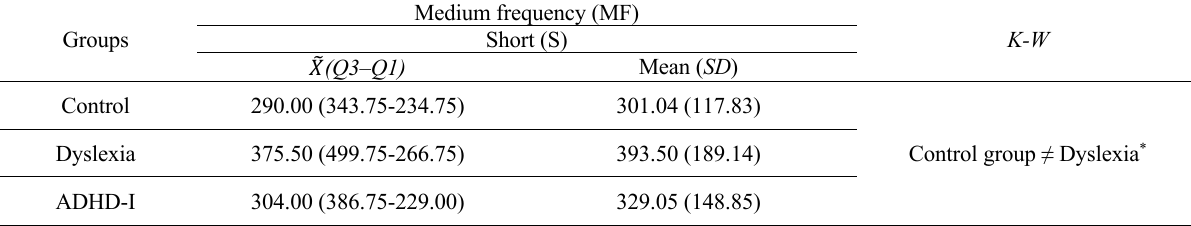
Table 6 – Median and Mean SFD duration (in milliseconds) on short x medium frequency target words in Dyslexia, Control and ADHD-I